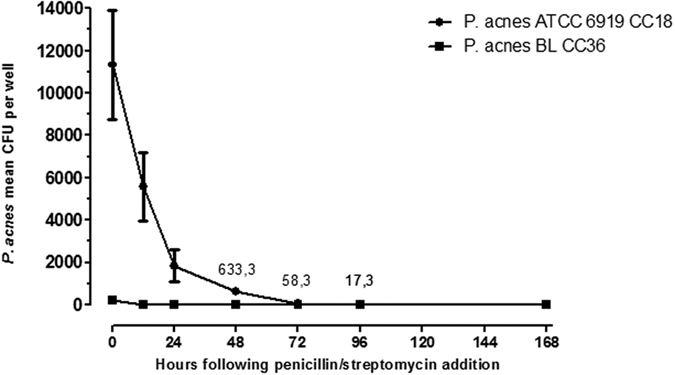
Persistence and viability of C. acnes strain ATCC6919 (CC18) and C. acnes BL (CC36) after internalization by MG-63 osteosarcoma cells.The mean CFU for three independent experiments for each time point is shown. Vertical lines represent the 95% confidence interval.